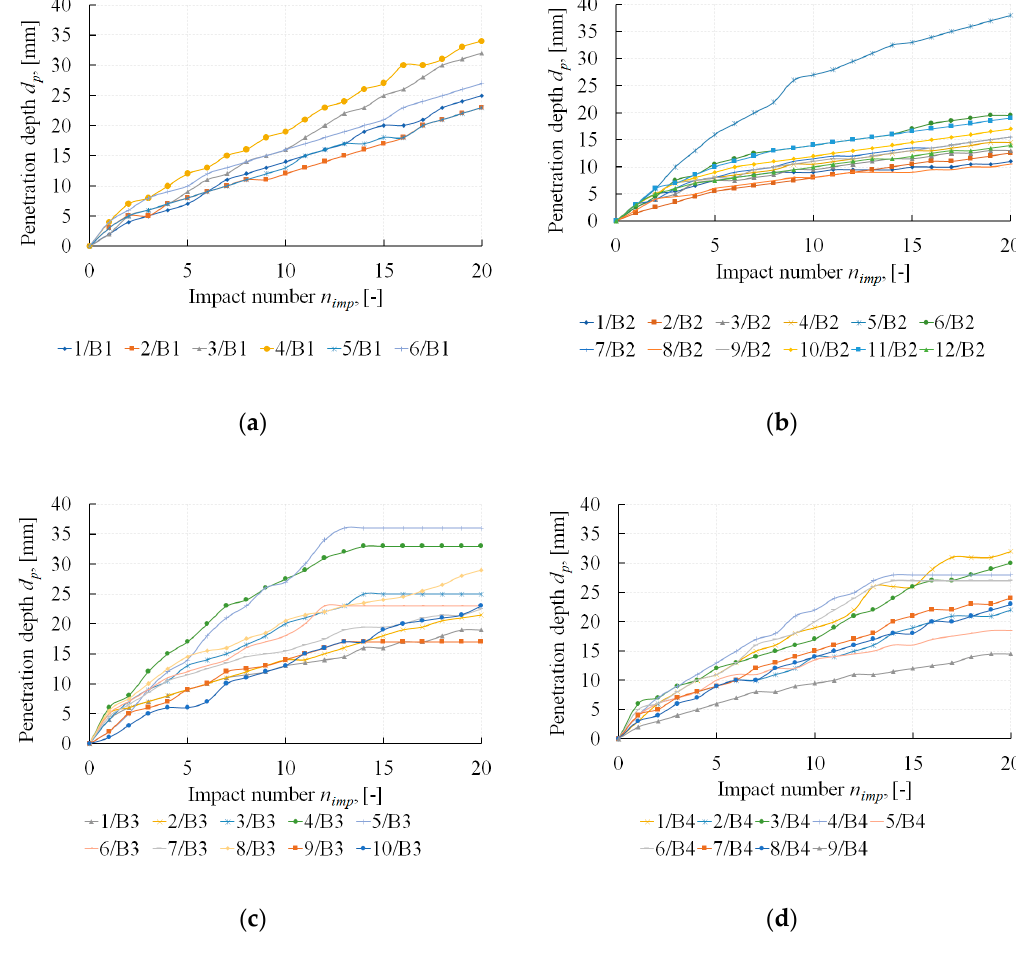
Figure 4. The results of penetrometer tests (PT)—the number of impacts vs. steel needle penetration depth: ( a ) tests in building B1; ( b ) tests in building B2; ( c ) tests in building B3; ( d ) tests in building B4.